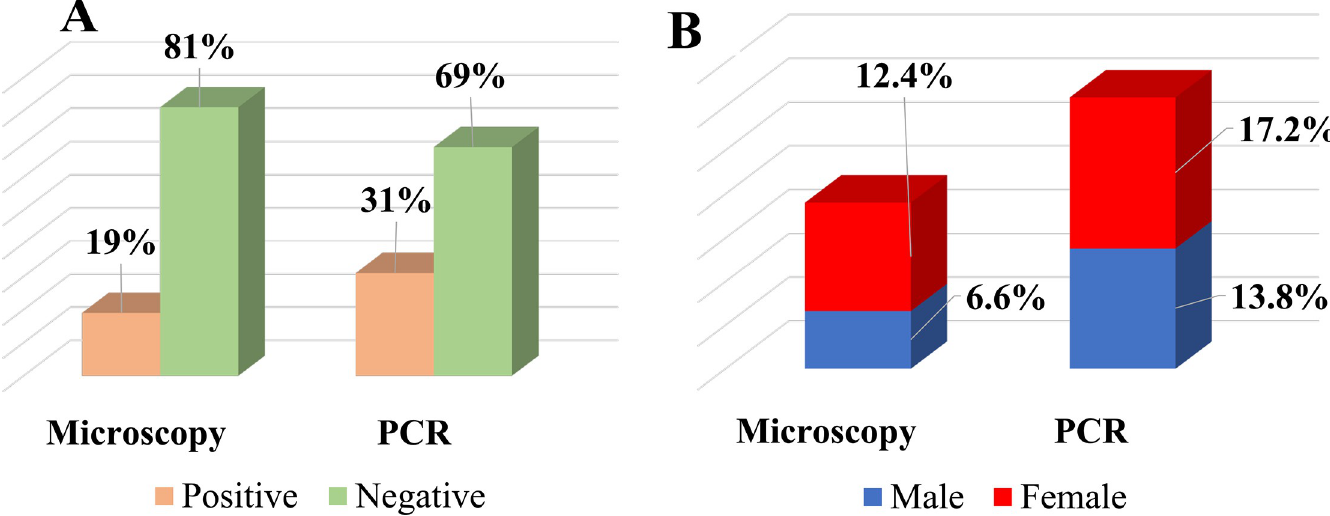
Fig 1. Prevalence of Plasmodium ssp infection using microscopy and PCR analysis. A. Comparison of the prevalence obtained by microscopy and PCR analysis. B. Repartition of Plasmodium spp infection by sex. Significance level ���� = P < 0.0001.